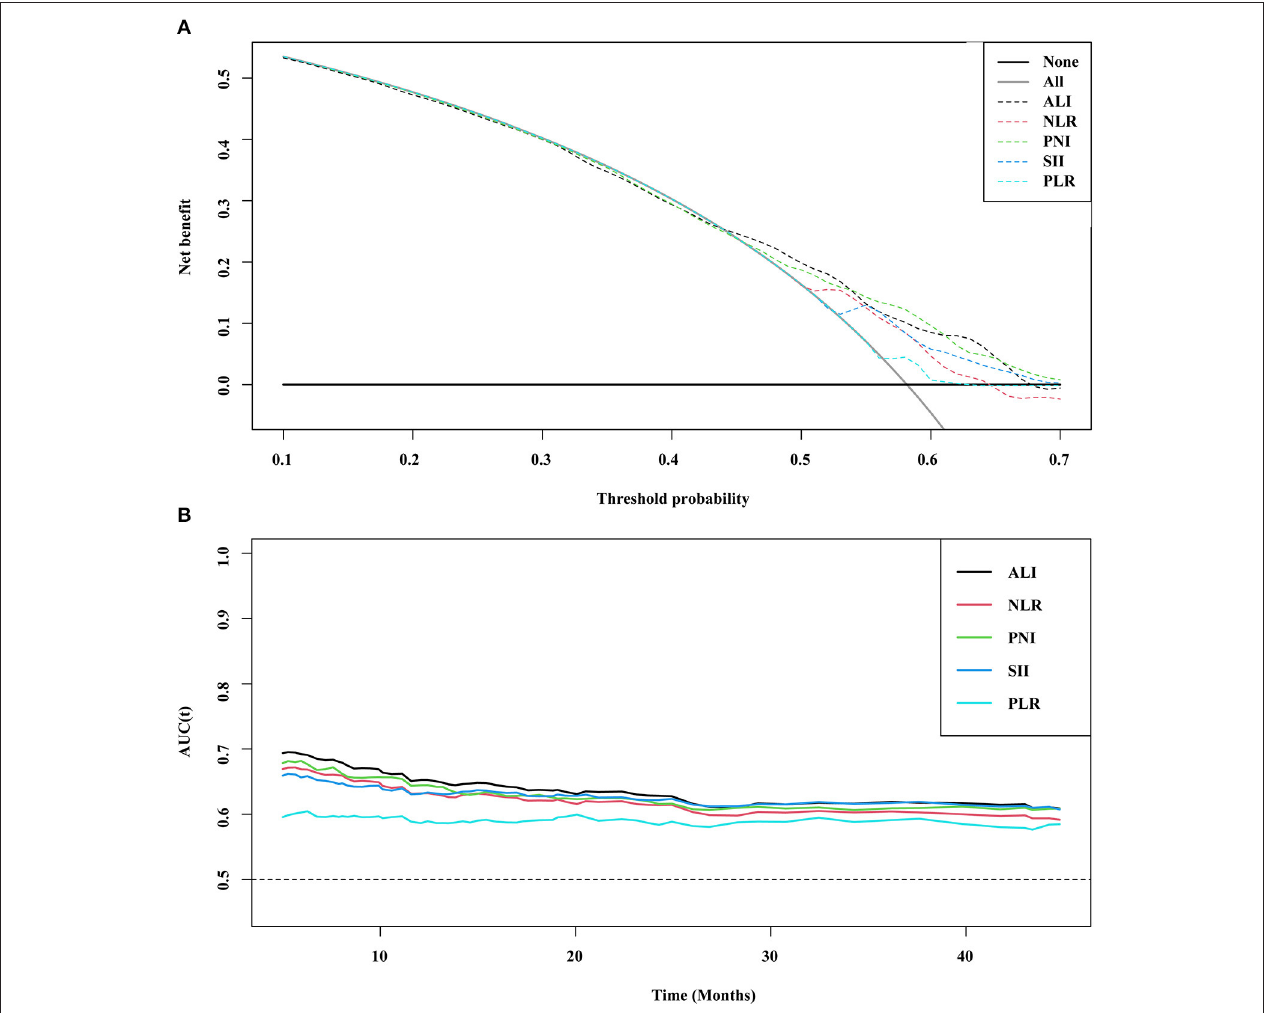
FIGURE 1 | DCA and prognostic ROC of different inflammation markers (A) DCA; (B) ROC. ALI, Advanced Lung Cancer Inflammation Index; NLR, Neutrophil-Lymphocyte Ratio; PNI, Prognostic Nutritional Index; SII, Systemic Immune-Inflammation Index; PLR, Platelet-Lymphocyte Ratio; ROC, Receiver Operating Characteristic Curve; DCA, Decision Curve